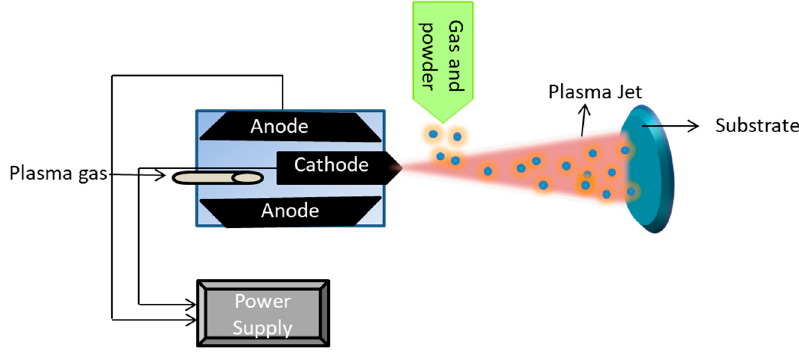
Figure 14. Schematic illustration of plasma spraying process which involves the spraying of powder (material to be coated) in the presence of plasma jet on the substrate. Plasma gas and powdered material are used as inputs.